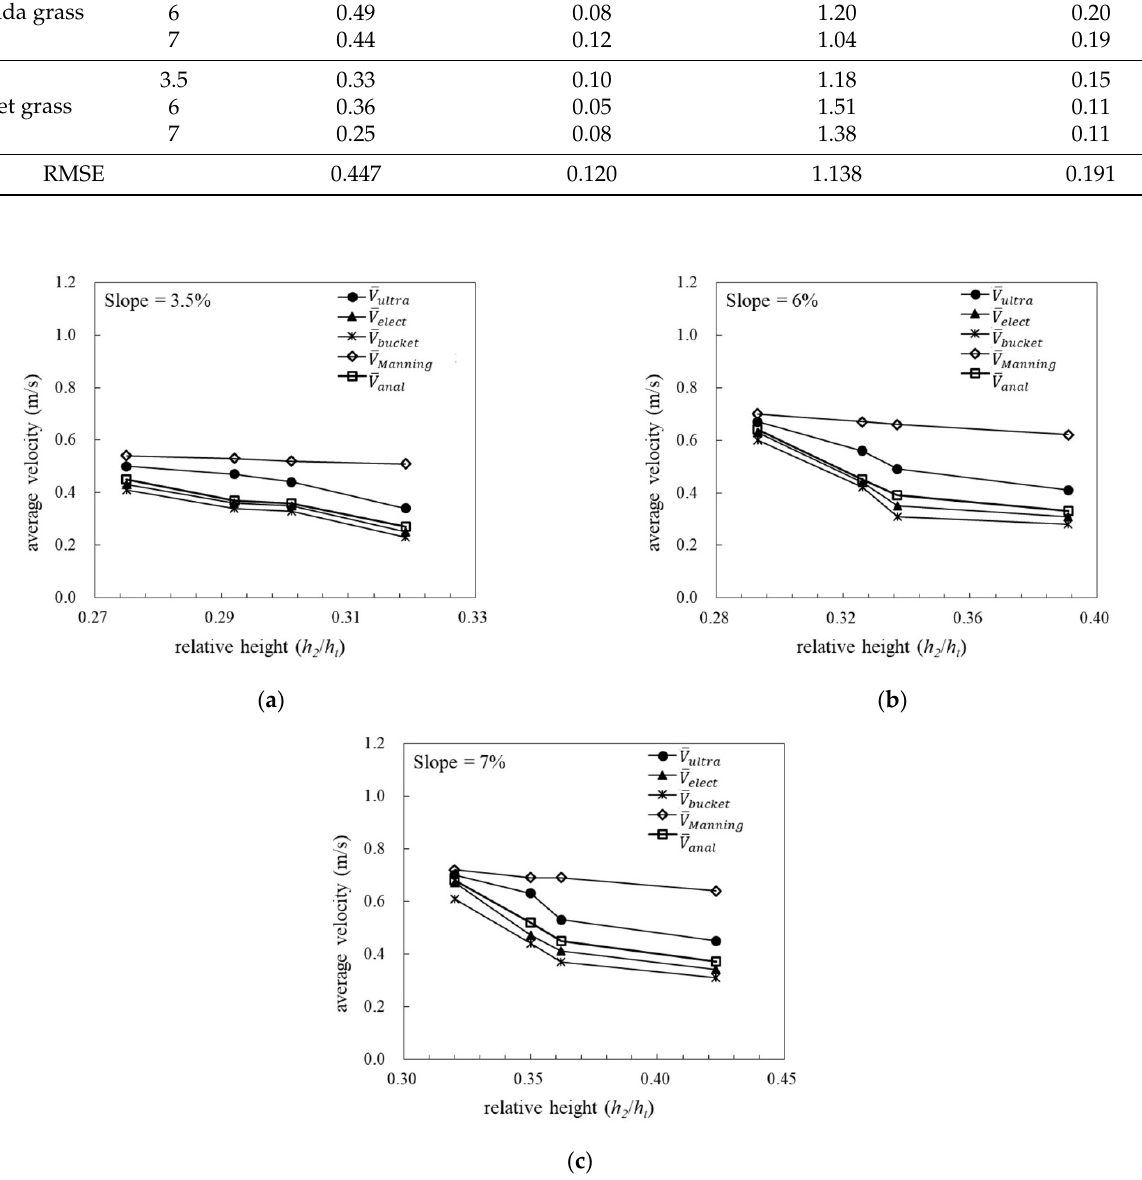
Figure 3. Average flow velocities at different relative heights for Centipede grass with a bed slope of ( a ) 3.5%, ( b ) 6%, and ( c ) 7%.